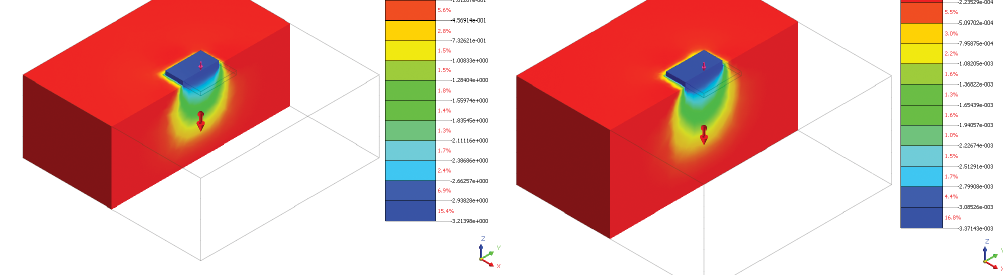
a) for 400 mm thickness b) for 500 mm thickness